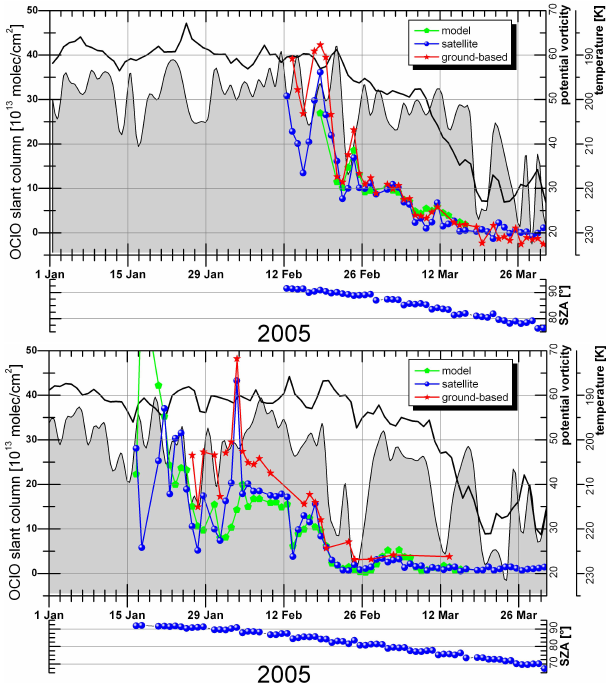
Fig. 4. Top: OClO slant columns over Ny- ˚Alesund (79 ◦ N, 12 ◦ E) in spring 2005 (axis on the left): Model data in green, satellite in blue and ground-based data in red. The ground-based data was sampled at the time of ENVISAT overpass. Also shown are poten- tial vorticity (shaded area; axis on the right) and temperature (black line; axis on the right) at the 475K isentropic surface. Bottom as top panel but for Summit, Greenland (73 ◦ N, 38 ◦